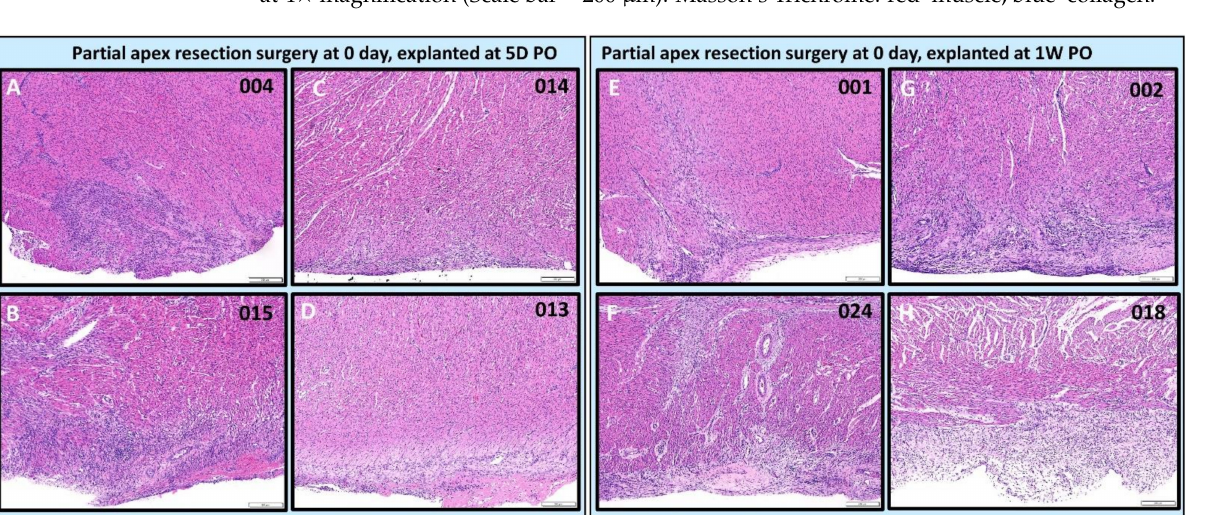
Figure 10. Partial apex resection surgery at 0 day and heart explants at 5D PO and 1W PO-Masson’s Trichrome histology of 0-day surgery heart explants obtained five days post-operation (5D PO): ( A ) Zero-day surgery heart from piglet #004. ( B ) Zero-day surgery heart from piglet #015. ( C ) Zero- day surgery heart from piglet #014. ( D ) Zero-day surgery heart from piglet #013. Masson’s Trichrome histology of 0-day surgery heart explants obtained one-week post-operation (1W PO): ( E ) Zero-day surgery heart from piglet #001. ( F ) Zero-day surgery heart from piglet #024. ( G ) Zero-day surgery heart from piglet #002. ( H ) Zero-day surgery heart from piglet #018. Histological images were taken at 4 × magnification (Scale bar = 200 µ m). Masson’s Trichrome: red–muscle; blue–collagen.